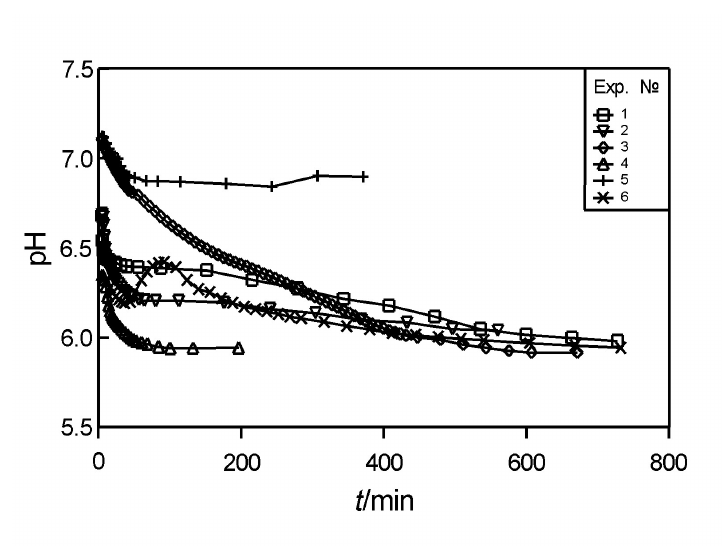
Figure 1. Graphs of pH vs. time for the six experiments listed in Table 1.